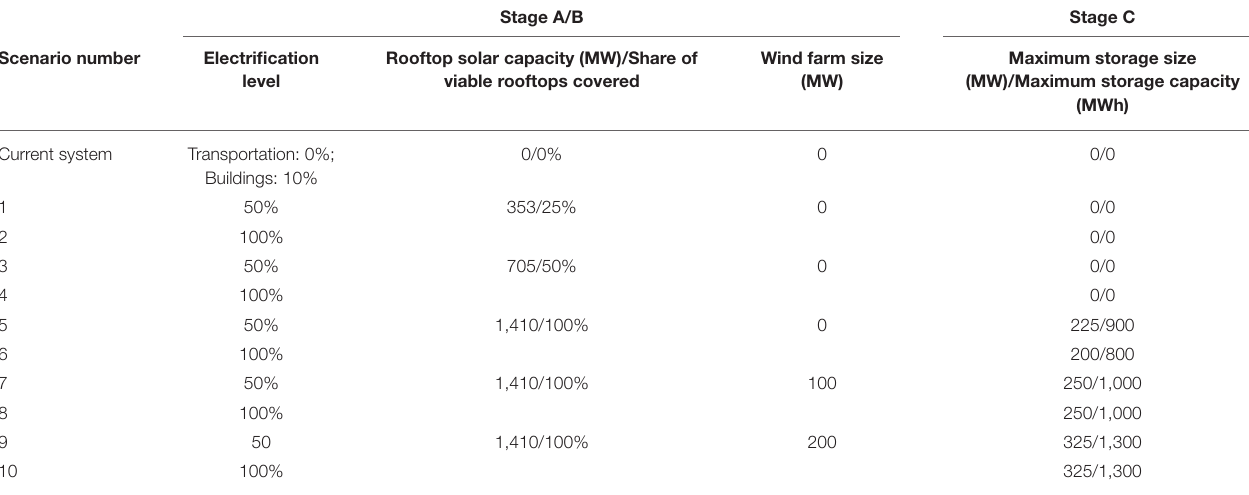
TABLE 1 | Scenario parameters.